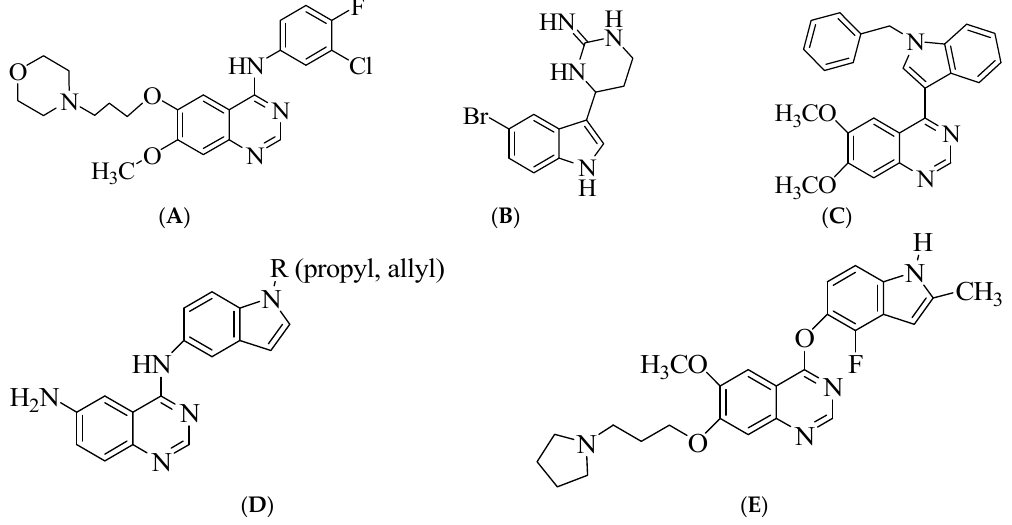
Figure 1. Structure of gefitinib ( A ), aplicyanin A ( B ) and indole-appended quinazoline hybrids ( C – E ) of biological importance. of biological